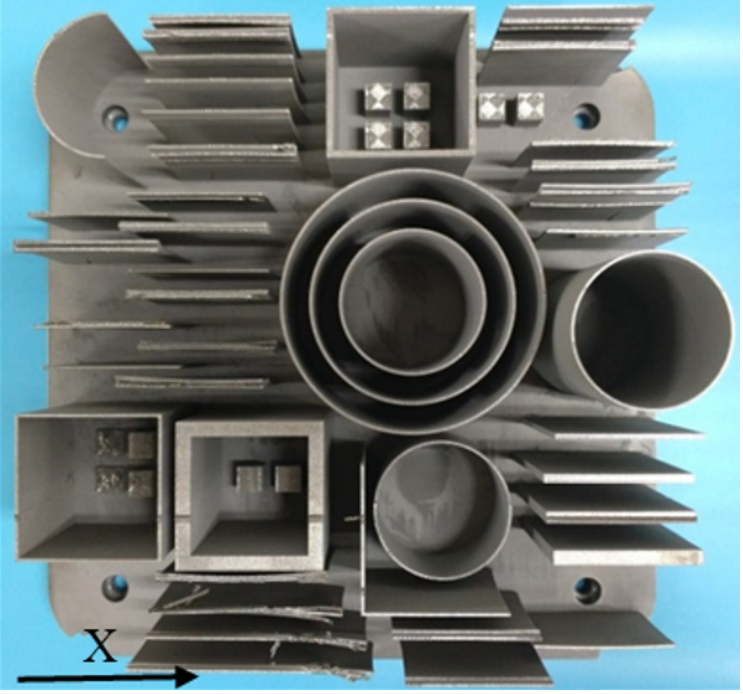
Figure 1. Typical thin-walled structures printed by LPBF.